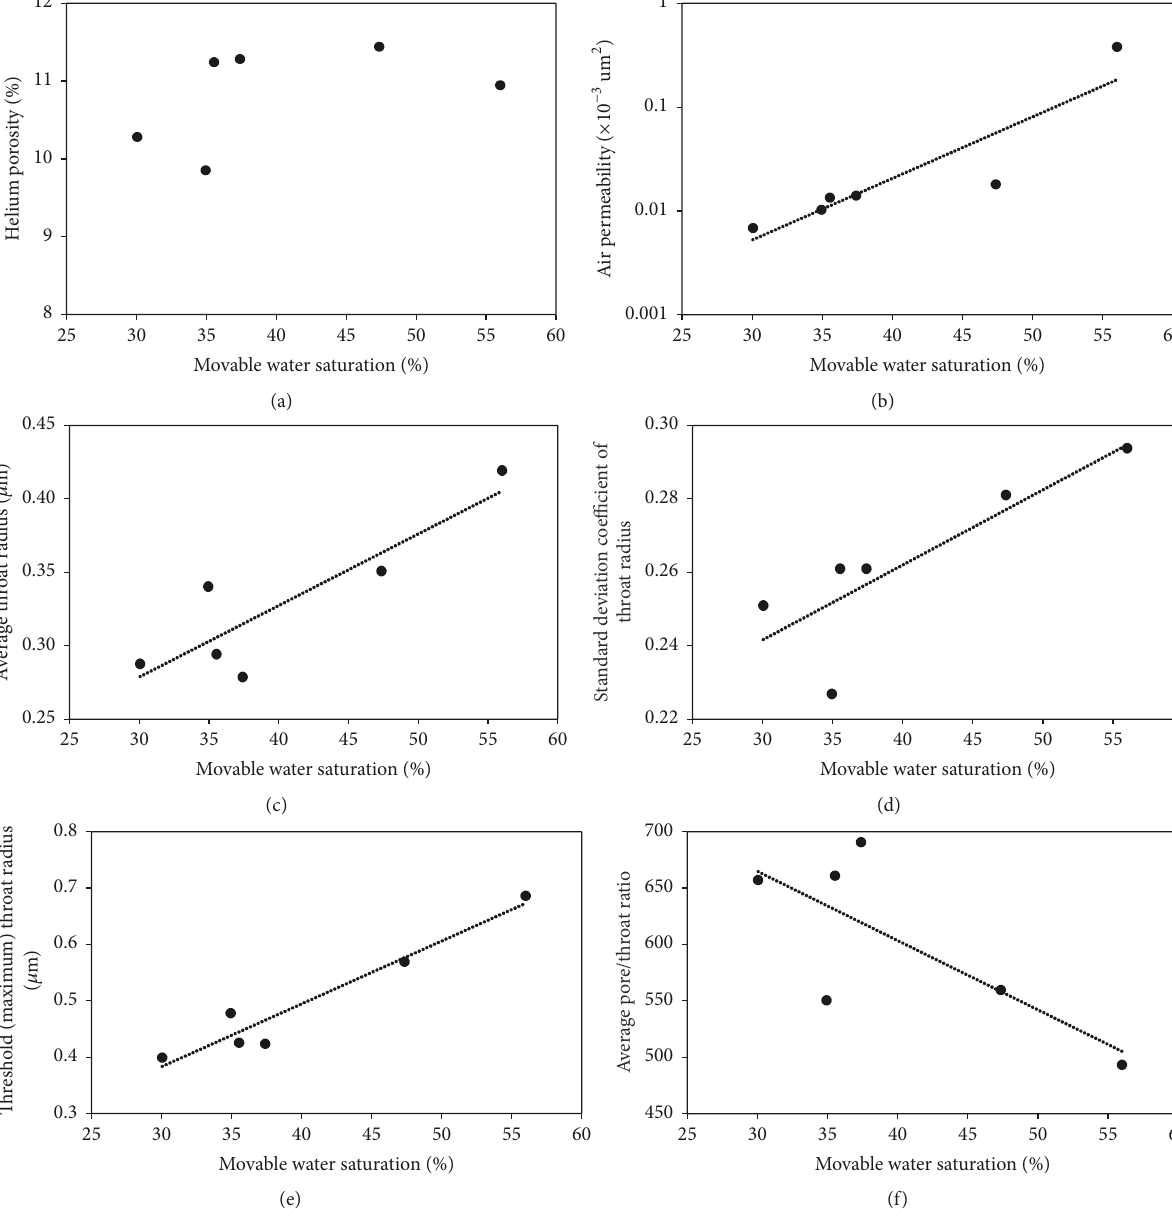
Figure 14: The correlation of pore-throat parameters and movable water saturation indicate that movable water saturation has a close relationship with throat geometry, which determined the permeability of the